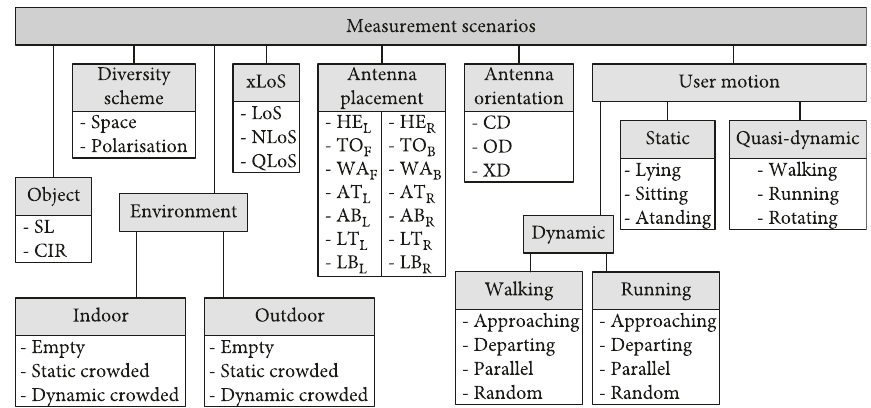
Figure 4: Classi fi cation of the measurement scenarios in o ff -body and body-to-body radio